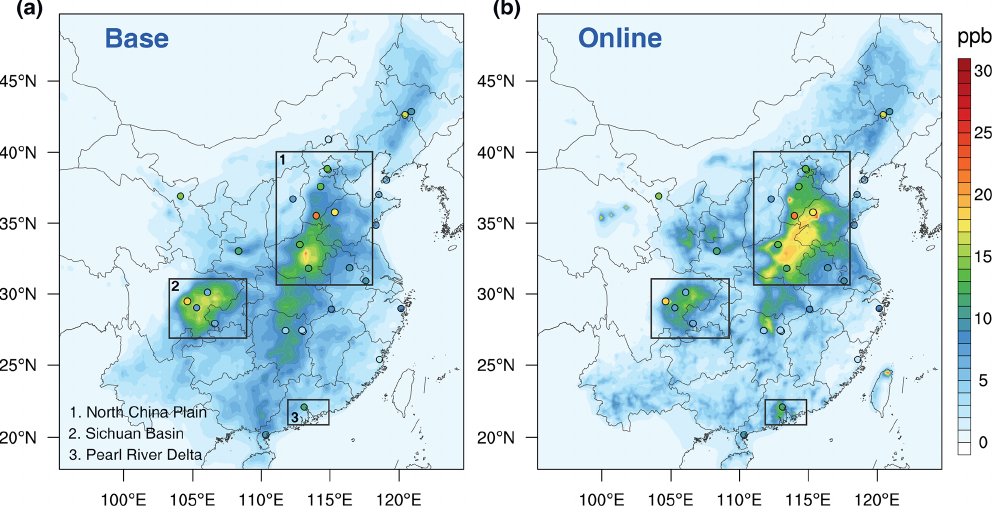
Figure 6. Spatial patterns of annual NH 3 concentrations over eastern China. The circles represent measured NH 3 concentration at the Nationwide Nitrogen Deposition Monitoring Network (NNDMN), averaged for 2010–2015. The contour plots represent model NH 3 in 2019 from the base experiment (a) and online experiment (b) of this study. The black rectangles represent the three focused regions in eastern China.